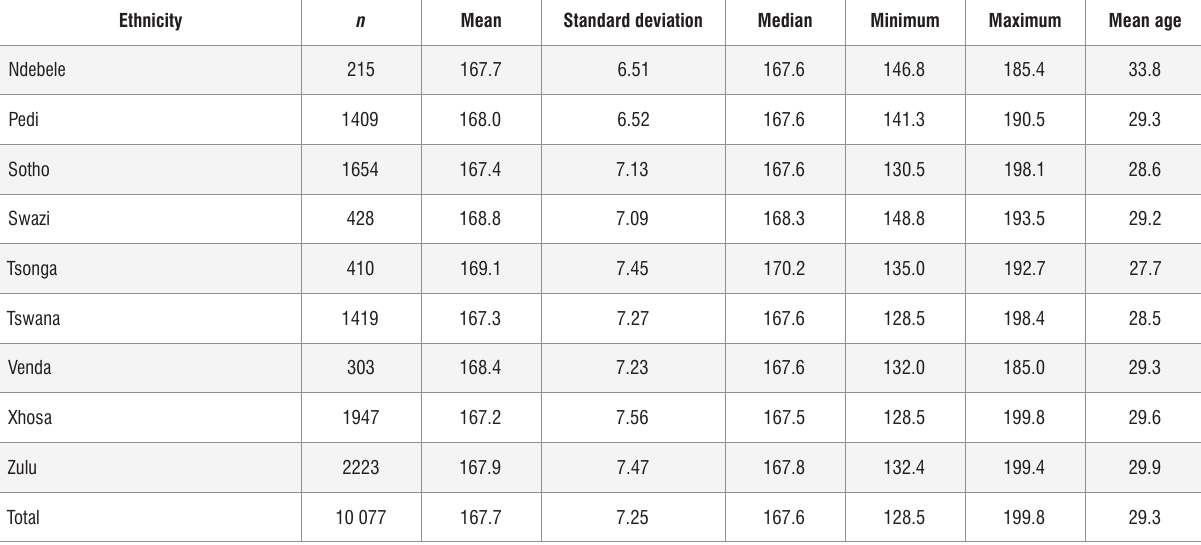
Summary of the statistics relating to heights of black men by ethnicity, 1895–1990 Ethnicity n Mean Standard deviation Median Minimum Maximum Ndebele 215 Pedi 1654 Swazi 428 Tsonga